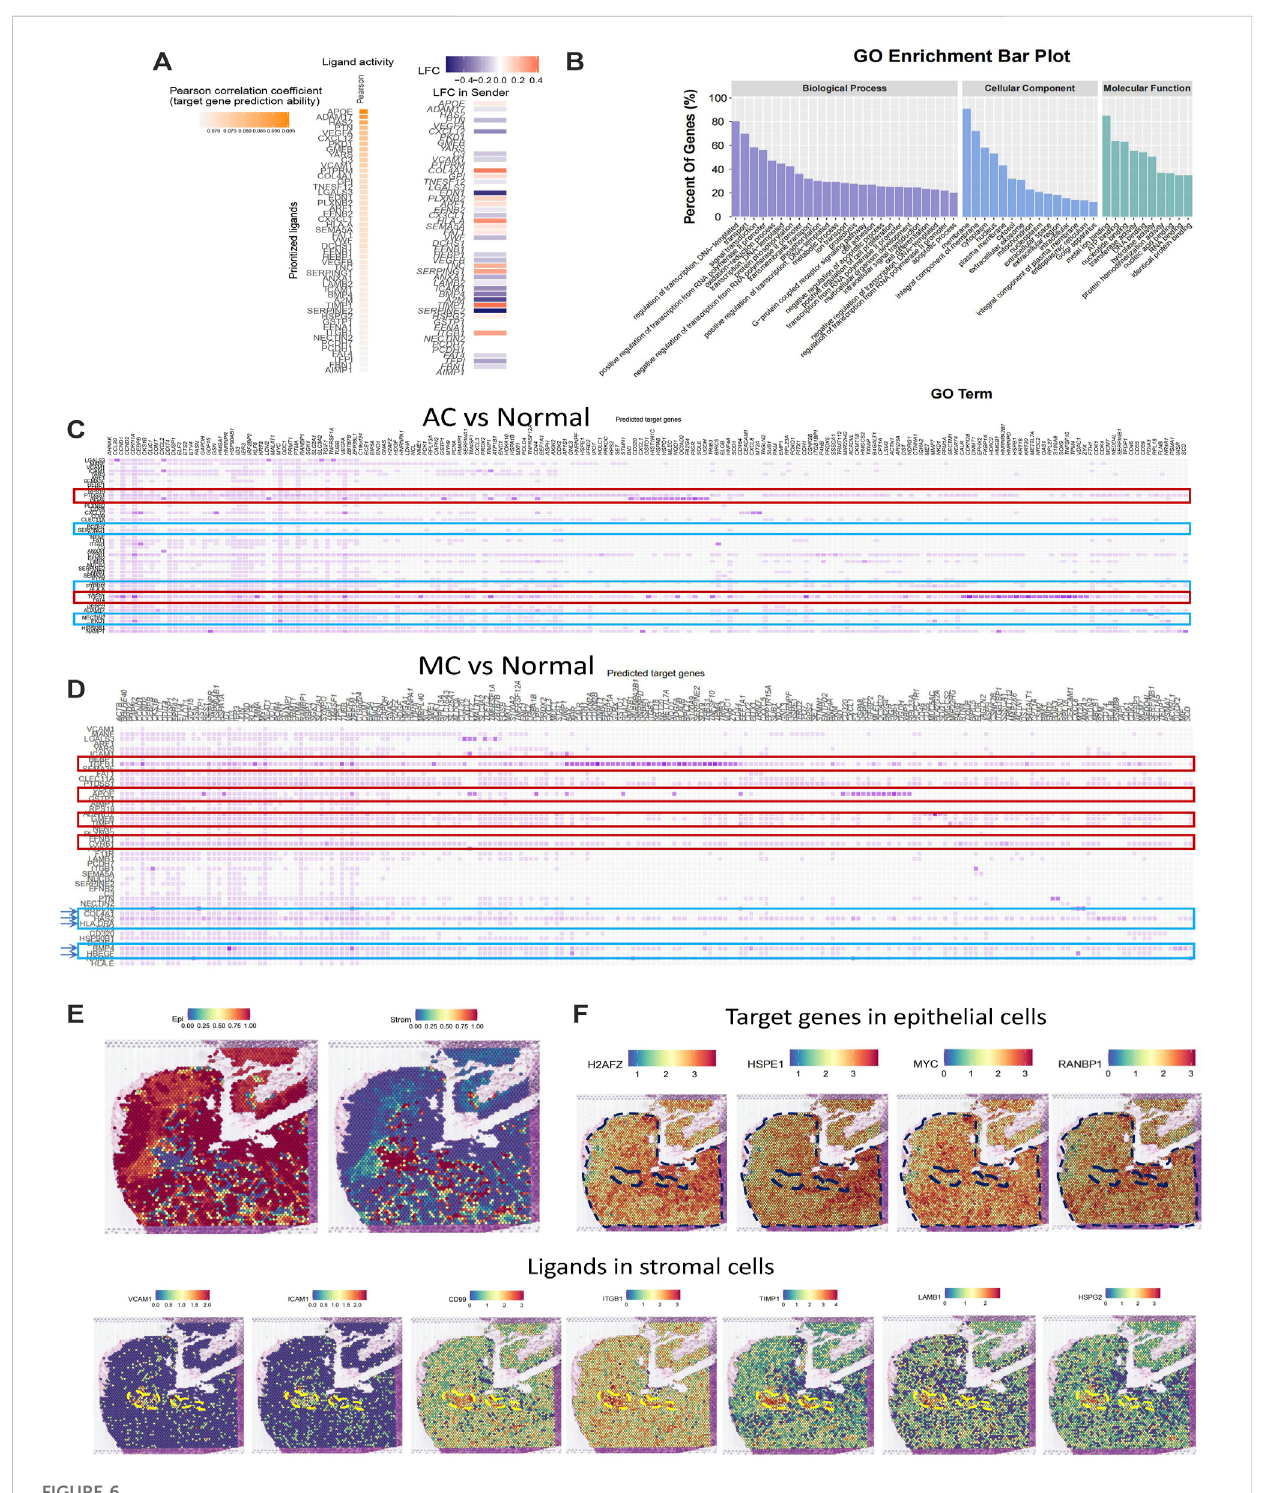
Stromalandepithelialcellinteractioninhumancolorectaladenocarcinomanototherwisespeci fi ed,mucinousadenocarcinoma,andnormalcolon. (A) Top ligands in stromal cells regulating epithelial cells predicted by NicheNet from colorectal adenocarcinoma not otherwise speci fi ed and mucinous adenocarcinoma with normal colon as the reference. (B) GO enrichment of top ligands from colorectal adenocarcinoma not otherwise speci fi ed and mucinous adenocarcinoma with normal colon as the reference. (C) Top ligands in stromal cells predicted by NicheNet from colorectal adenocarcinoma not otherwise speci fi ed with normal colon as the reference and their target genes in epithelial cells. (D) Top ligands in stromal cells predicted by NicheNet from mucinous with normal colon as the reference and their target genes in epithelial cells. (E) Cell annotation on spatial transcriptome data on human colorectal adenocarcinoma not otherwise speci fi ed. (F) Spatial feature plot of target genes in epithelial cells and ligands in stromal cells predicted by NicheNet from colorectal adenocarcinoma not otherwise speci fi ed with normal colon as the